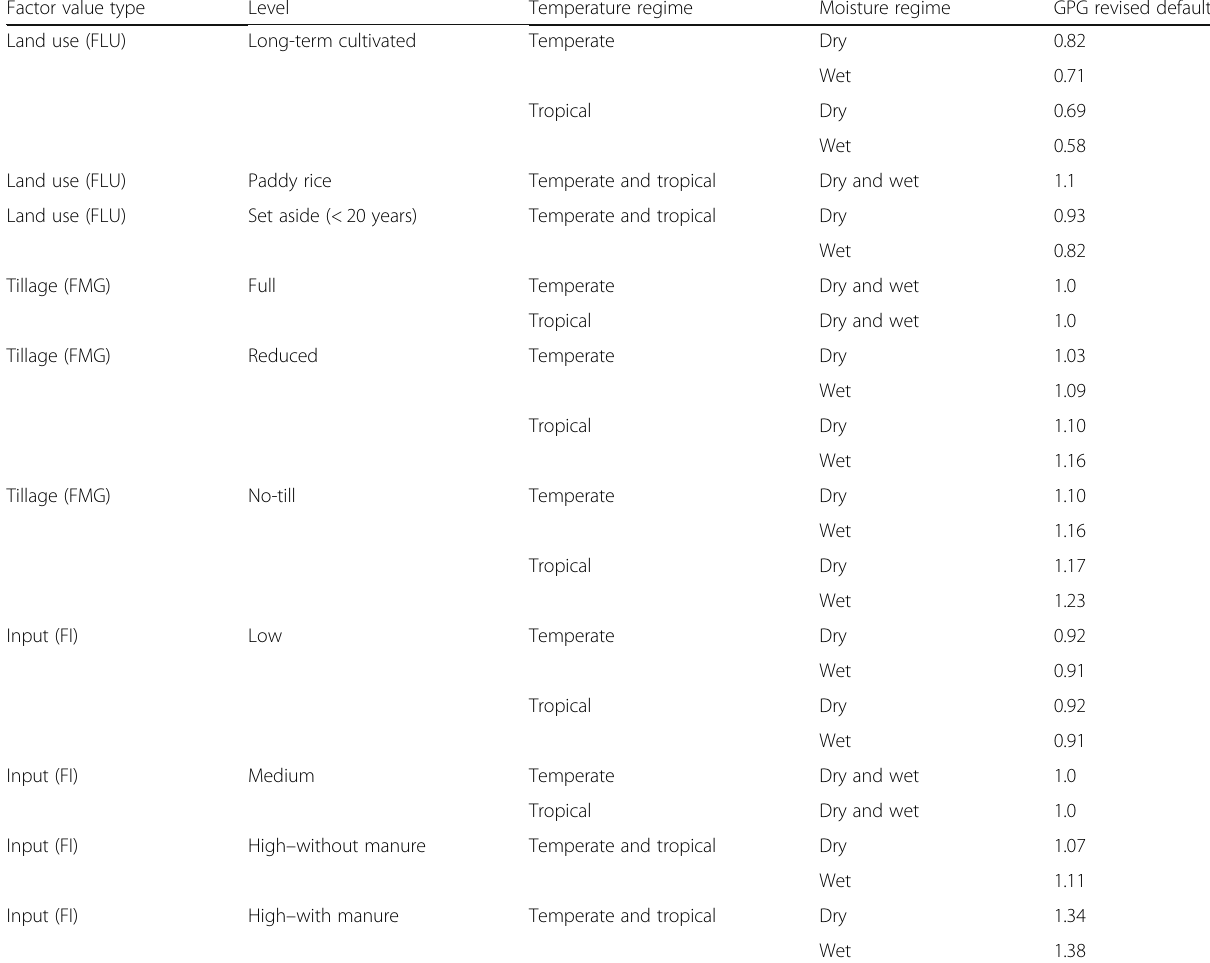
Table 3 Relative stock change factors (FLU, FMG, and FI) (over 20 years) for different management activities on cropland Factor value